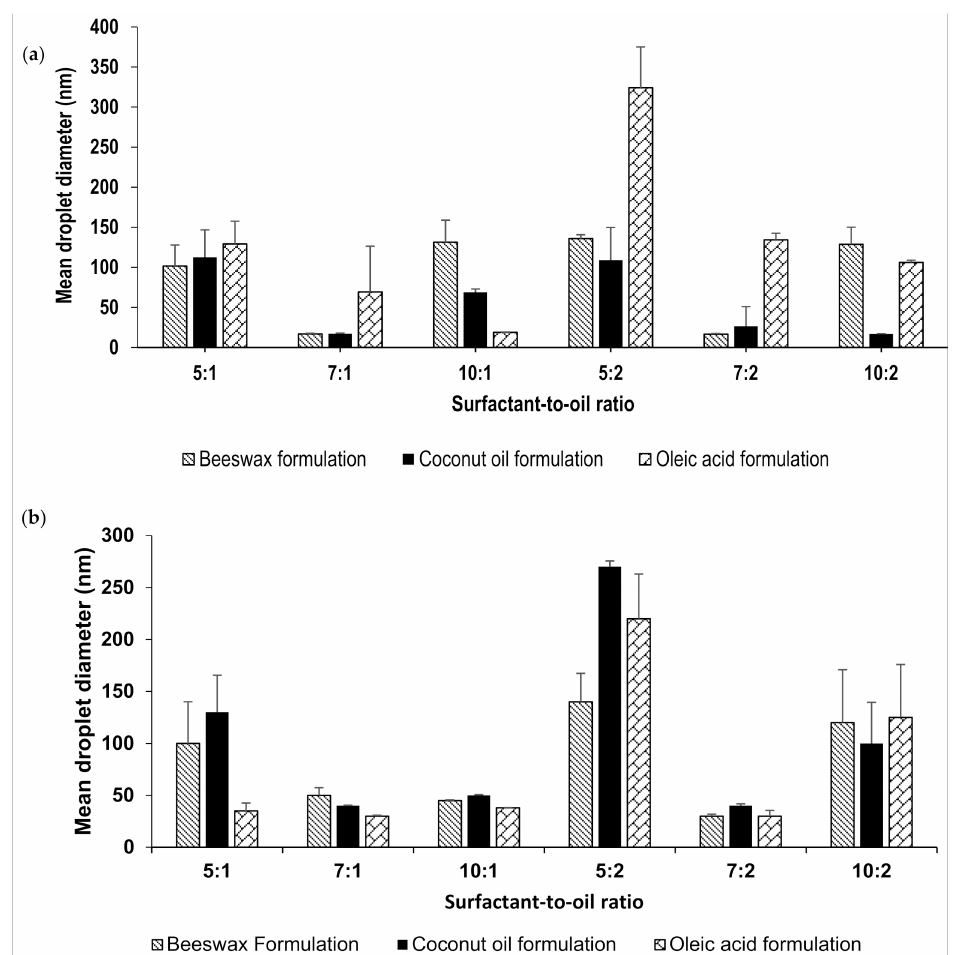
Figure 1. ( a ) Mean droplet size of fresh lidocaine nanoemulsions prepared at different SOR ratios and ( b ) Mean droplet size of lidocaine nanoemulsions after 7